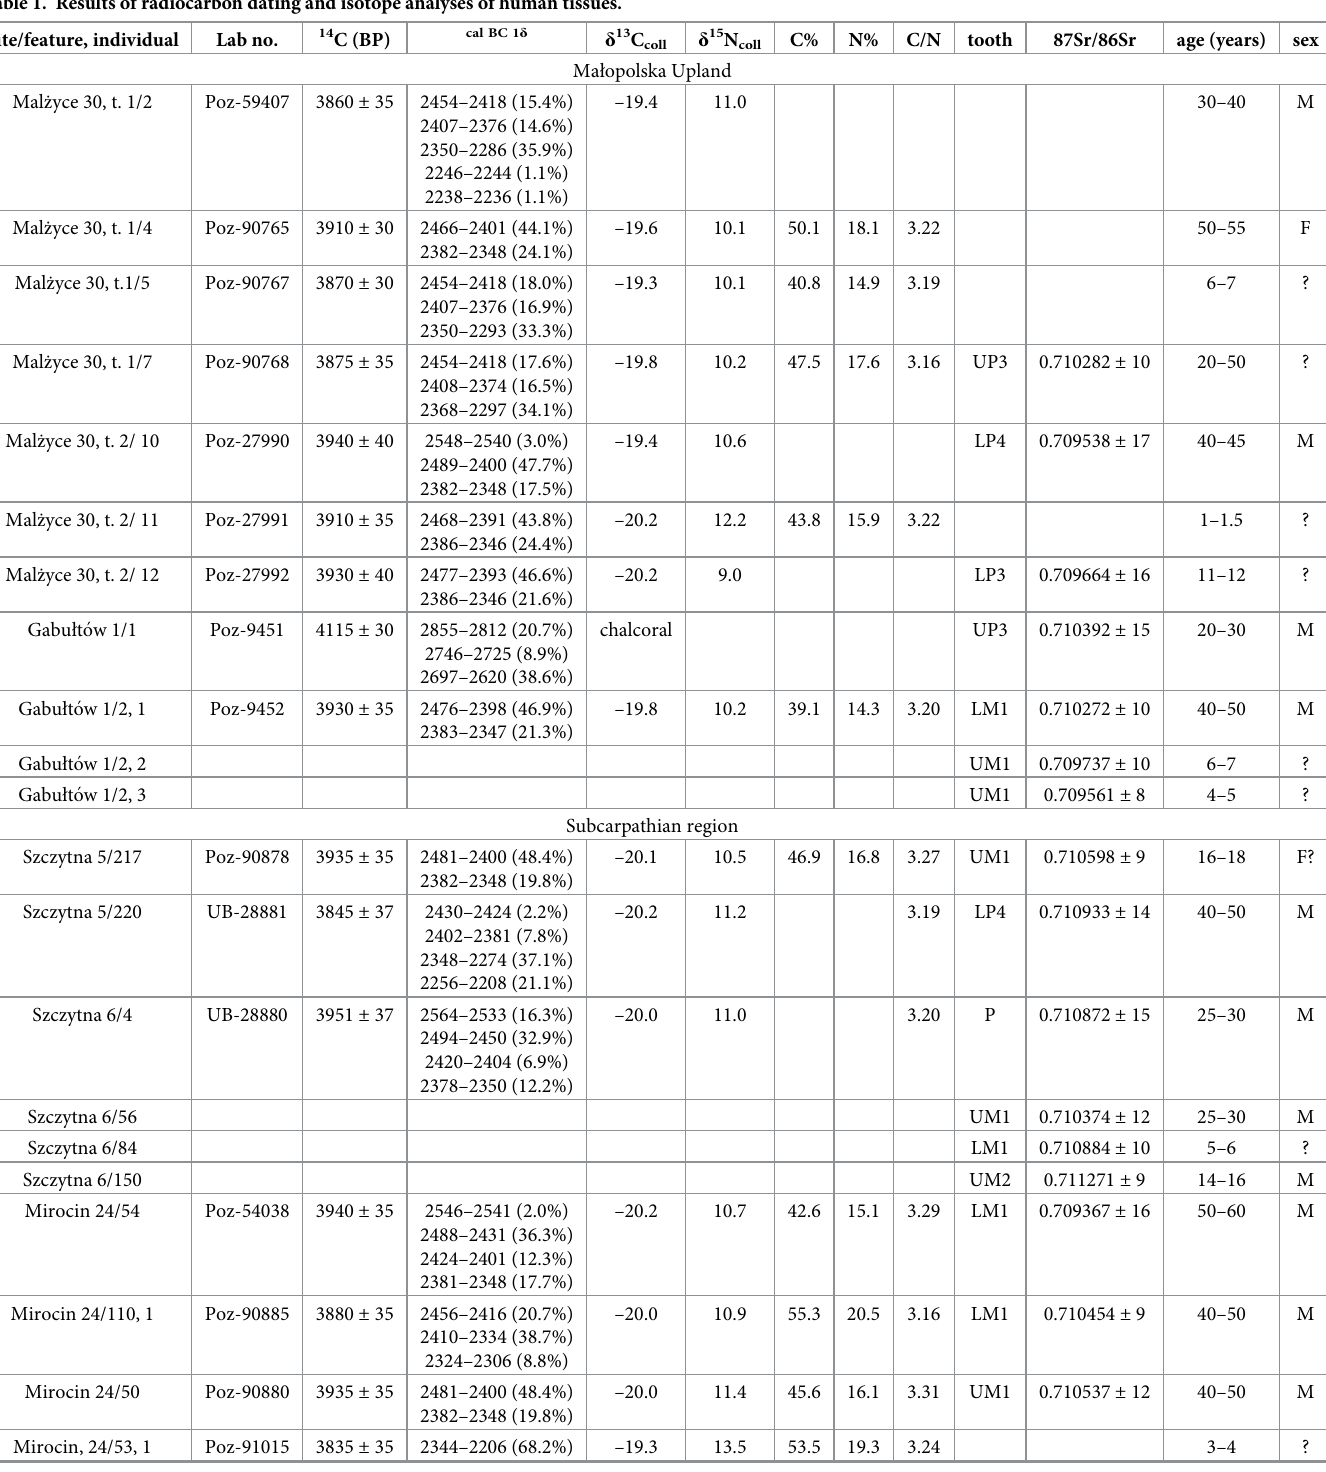
Table 1. Results of radiocarbon dating and isotope analyses of human tissues. Site/feature,